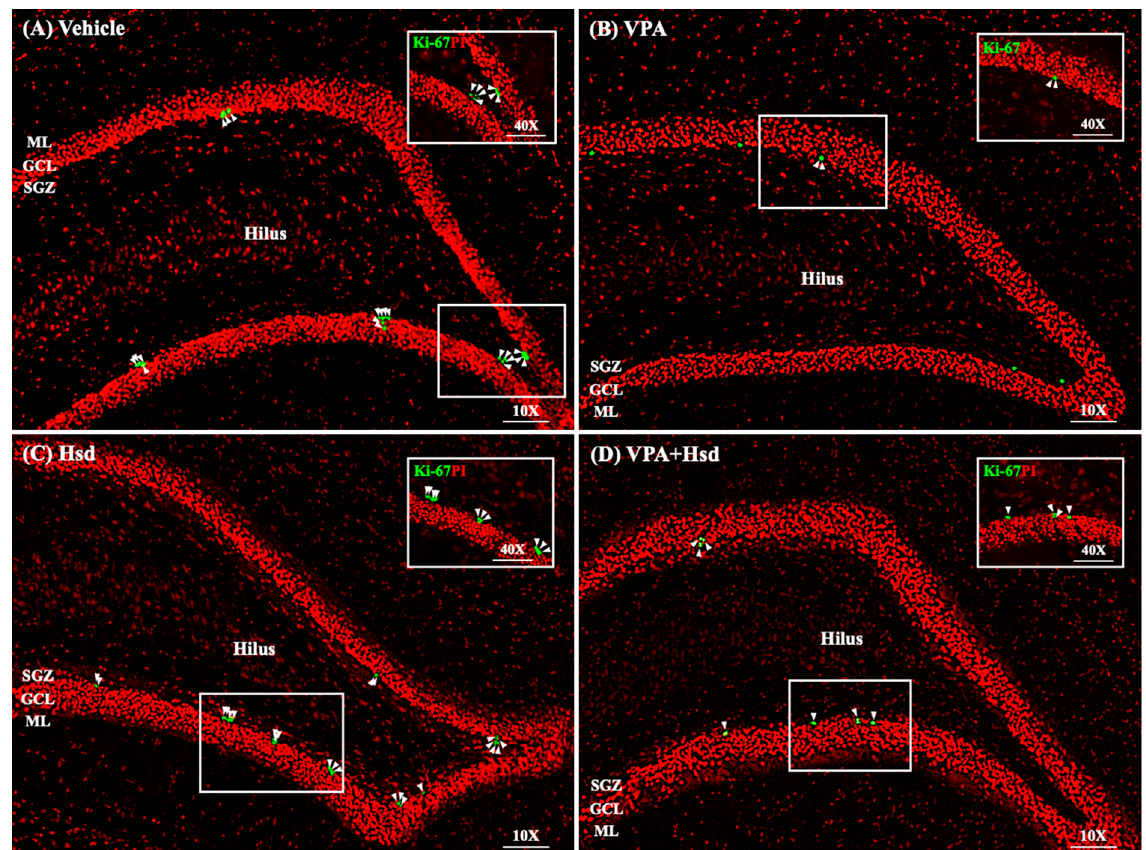
Figure 5. Images of Ki-67-positive cells (green) in the subgranular (SGZ) of the hippocampal dentate gyrus (DG) ( A – D ). All nuclei were counterstained with propidium iodide (red). Arrowheads indicate Ki-67-positive cells in the DG (scale bars: 100 μ m). The inserted figures show Ki-67 immunostaining at high magnification (scale bars: 50 μ m).